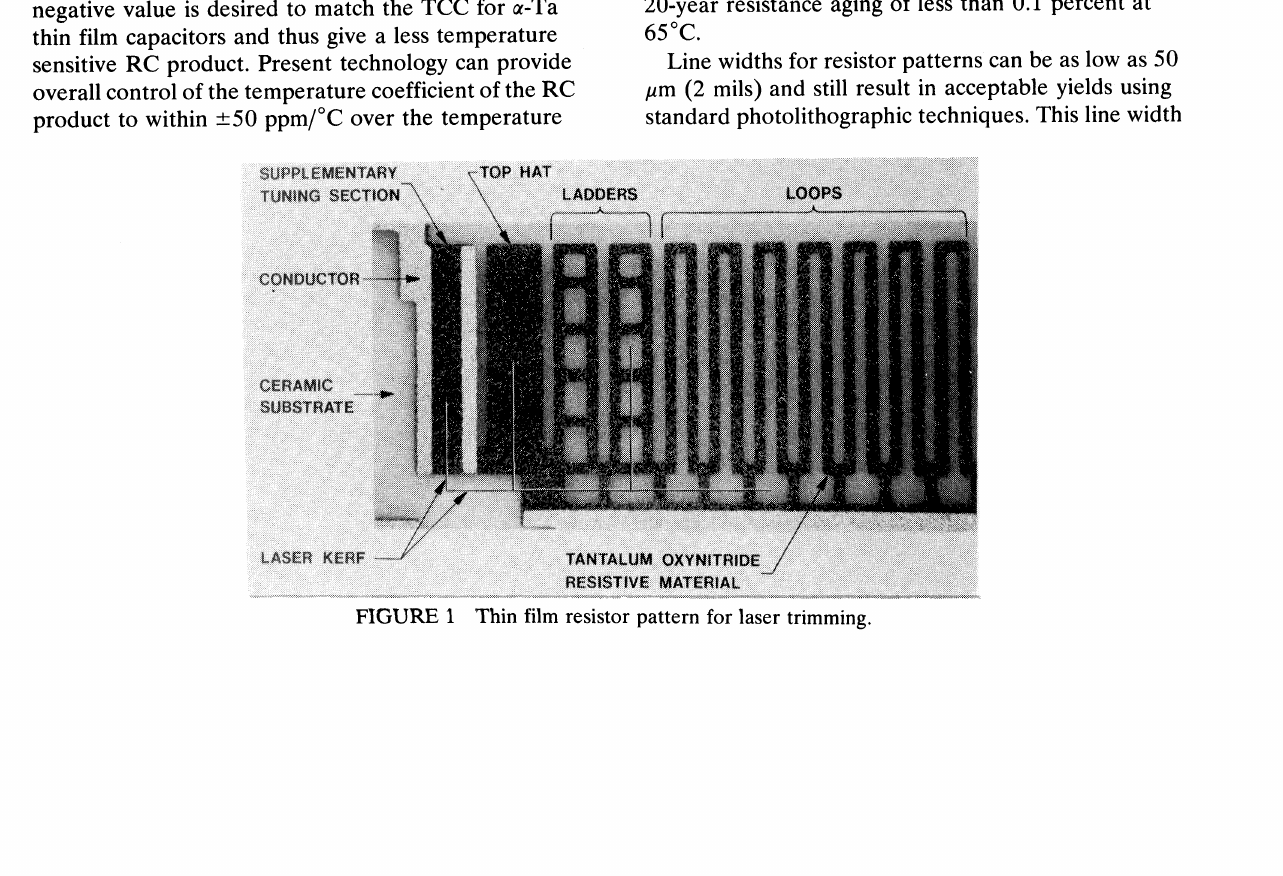
Thin film resistor pattern for laser